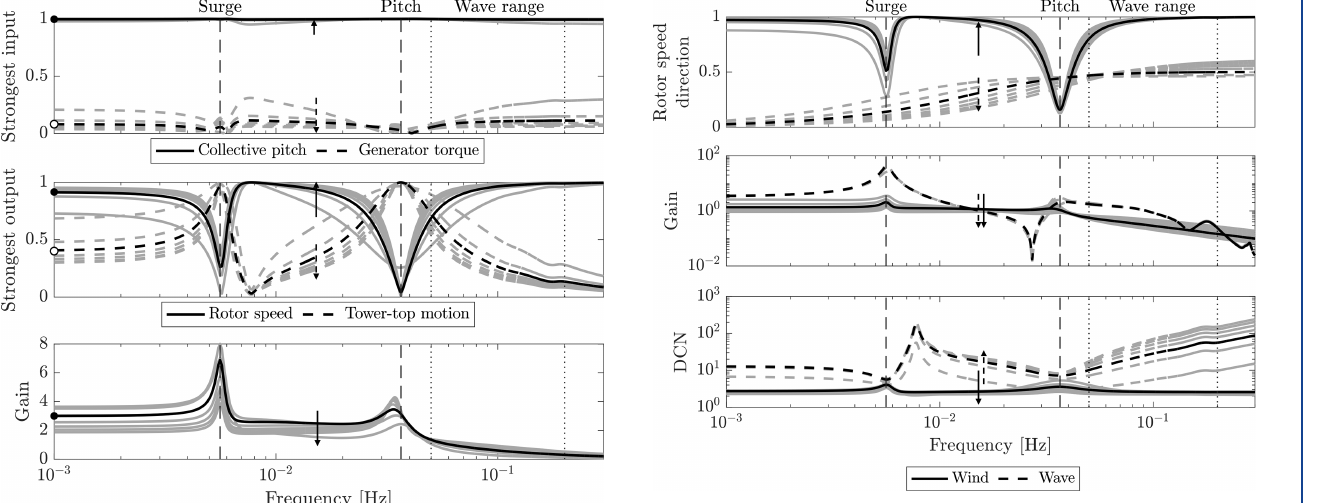
Figure 1. Singular value decomposition of the floating wind turbine plant for several above-rated operating points (grey, arrows for in- creasing wind), and for the 16m/s wind case (black). Values for the zero-frequency case are displayed by the marks • and ◦ . The verti- cal dashed lines are the frequency of the platform surge and pitch modes; the frequency range where waves are active is enclosed by the vertical dotted lines.